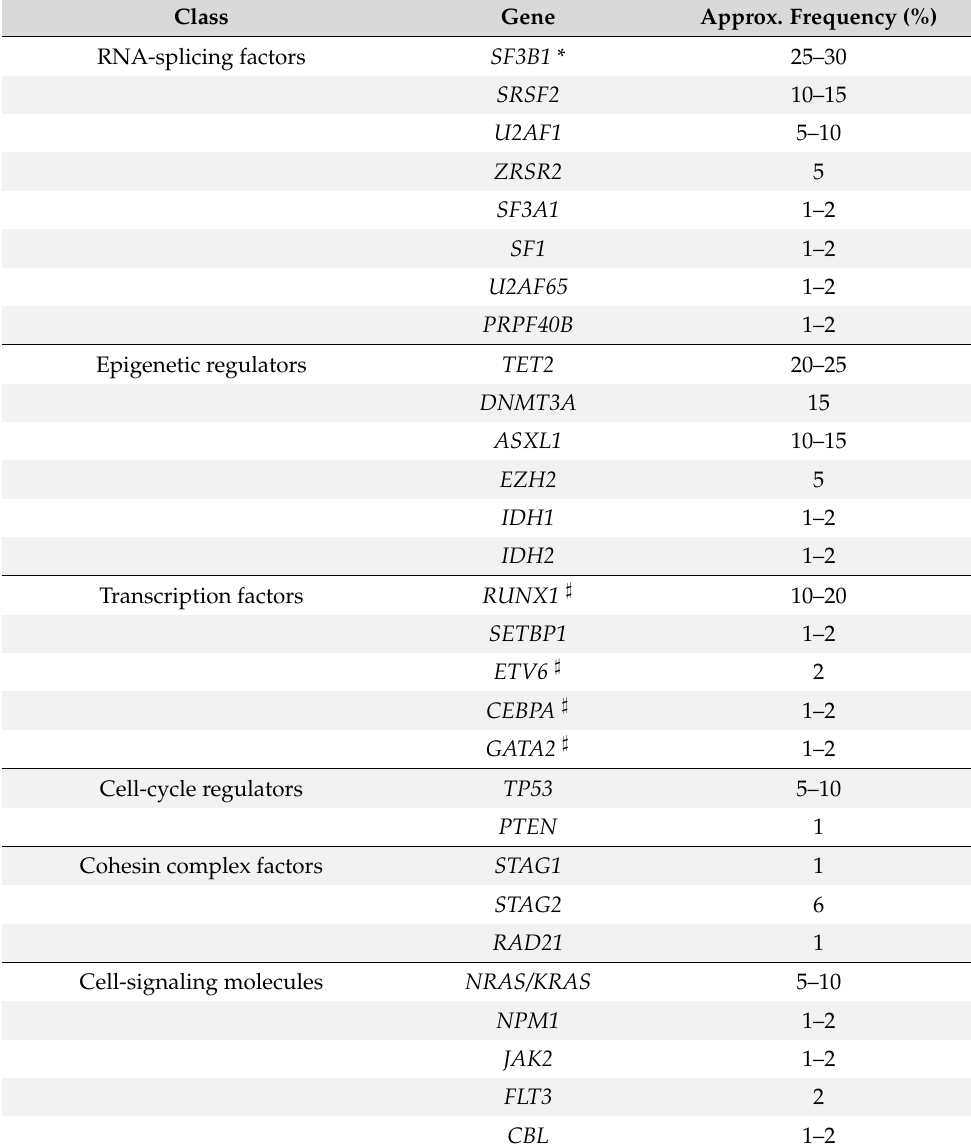
Table 1. Recurrently mutated leukemia associated driver genes in MDS